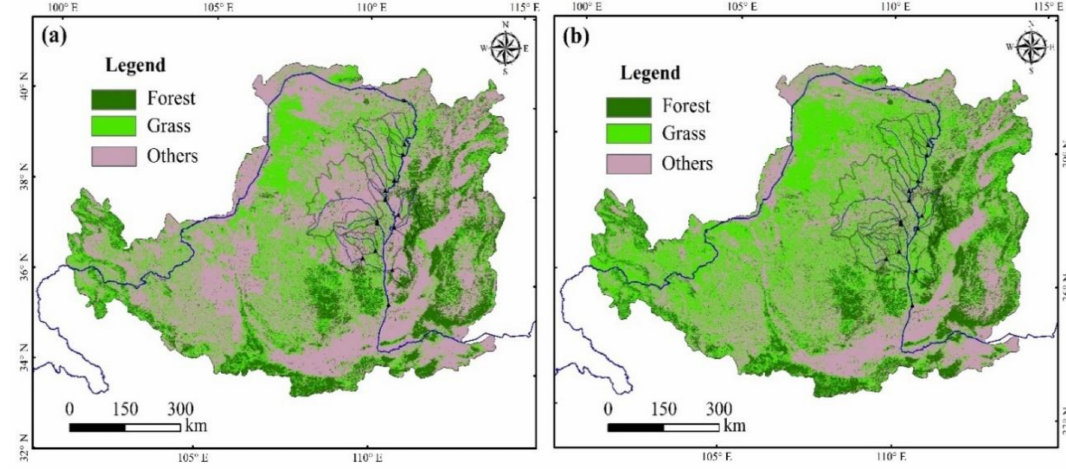
Figure 12. Spatial distribution of vegetation cover in ( a ) 2000 and ( b ) 2015 in the Loess Plateau.